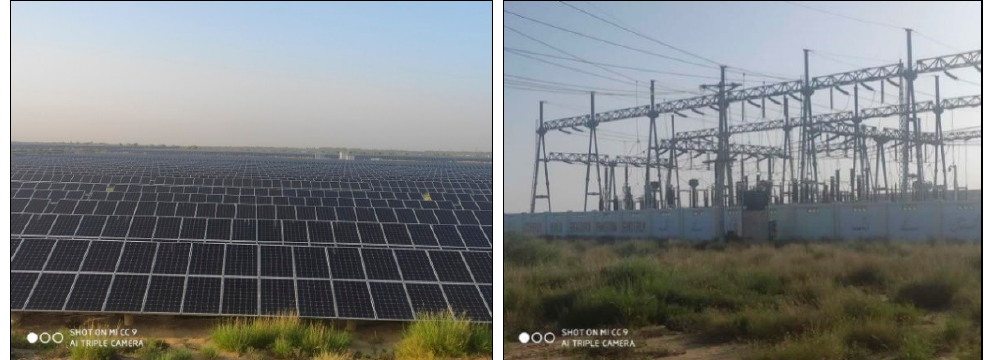
Figure 1. Photovoltaic power station in Quaid-e-Azam Solar Park, Pakistan. Source: photographed by the author.